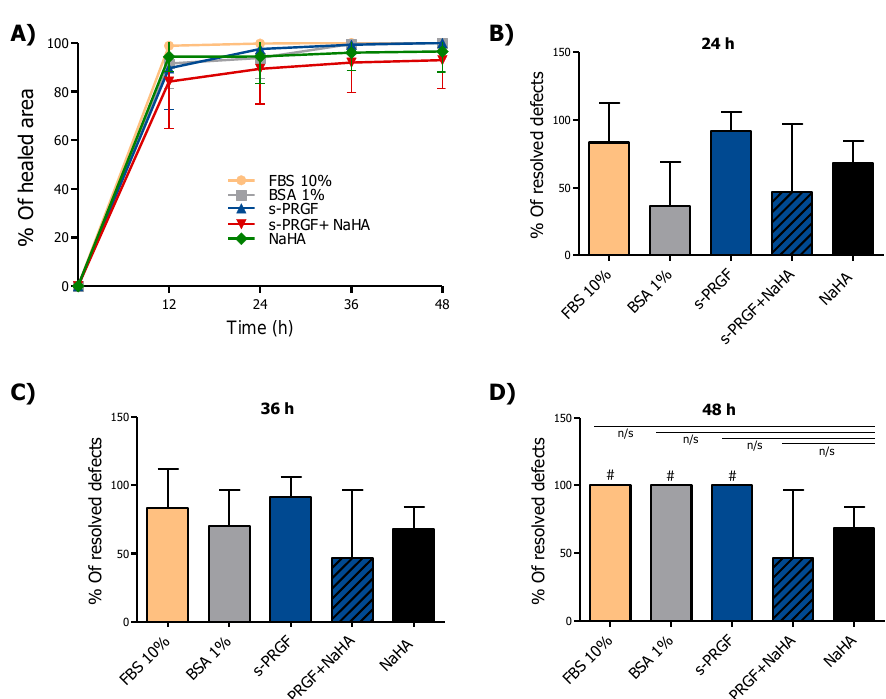
Figure 3. Effect of s-PRGF, alone or combined with NaHA, on the re-epithelialization of rabbit primary corneal epithelial (RPCE) cultures. Cultures were exposed for 72 h to 10% FBS; 45% s-PRGF; 45% s-PRGF + 0.1% NaHA (combined treatment); 0.1% NaHA; and 1% BSA as a negative control. The percentage of re-epithelialized area of RPCE cultures after 48 hr ( A ), and percentage of wells in which the defect in the monolayer had completely resolved at 24 ( B ), 36 ( C ) and 48 ( D ) hours are shown. Statistically significant differences with respect to the combined s-PRGF + NaHA treatment (#) (# p < 0.05; n/s, not significant. χ 2 test and Fisher’s exact